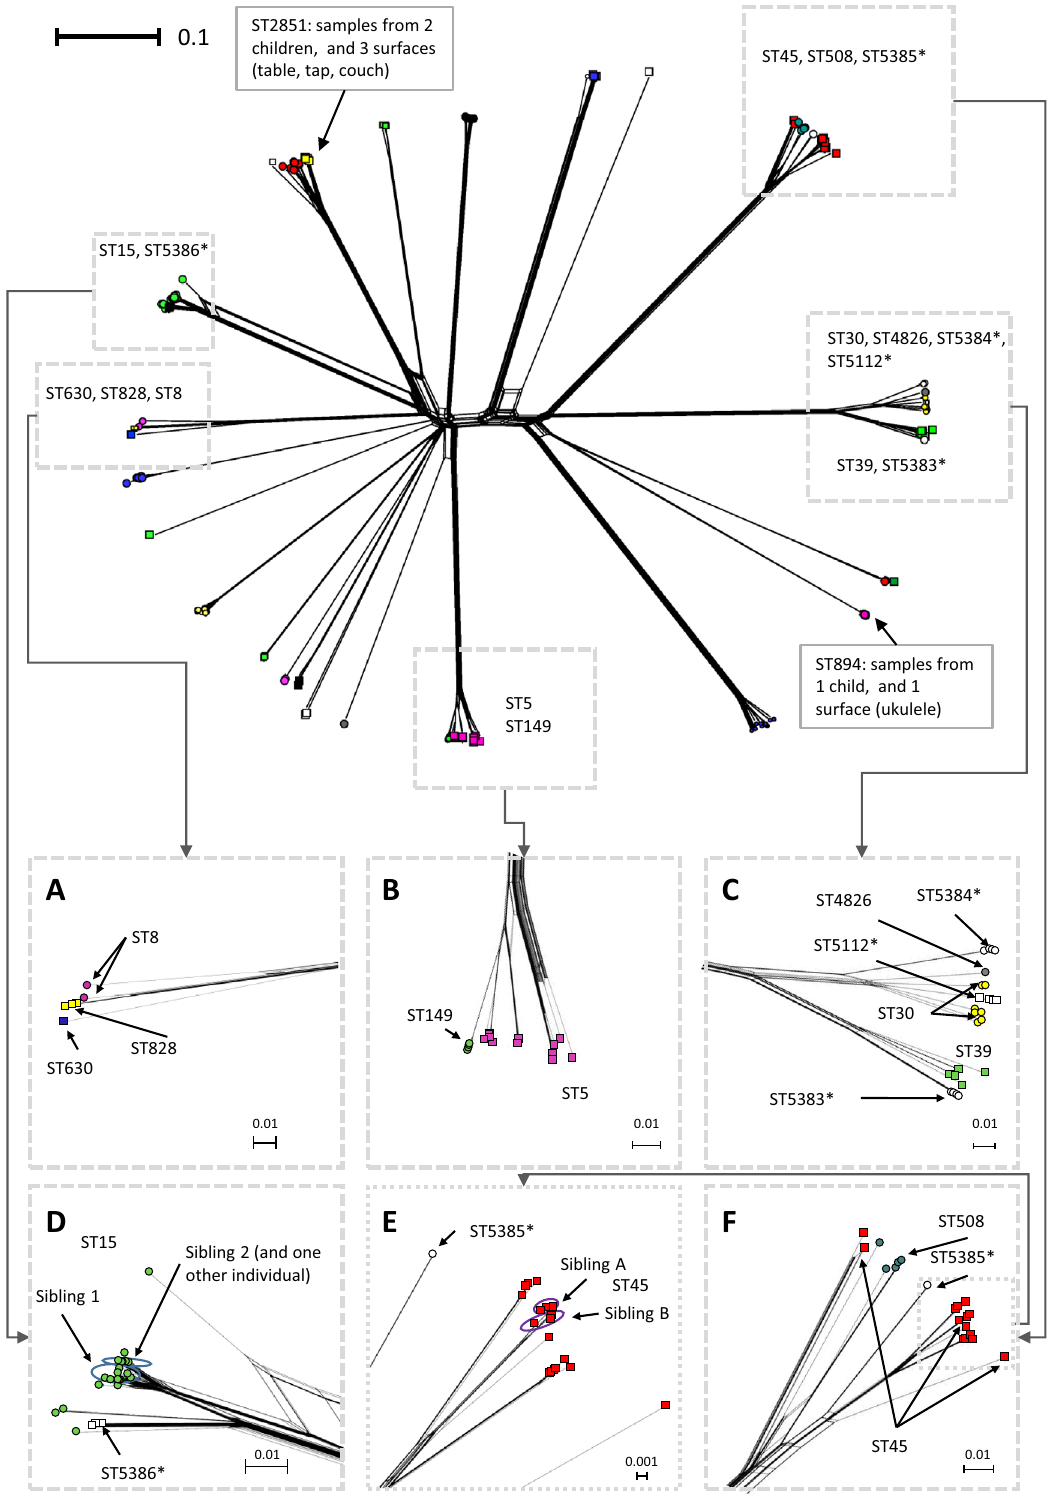
Figure 4. Phylogenic network plot, full dataset. Isolates from the same ST have same shape and colour. Symbols with no fill and/or ST number with asterisk indicate MLST types newly registered from this